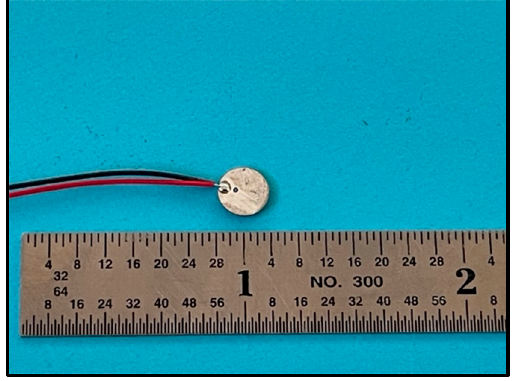
Figure 1. Piezoelectric sensor with leads attached.